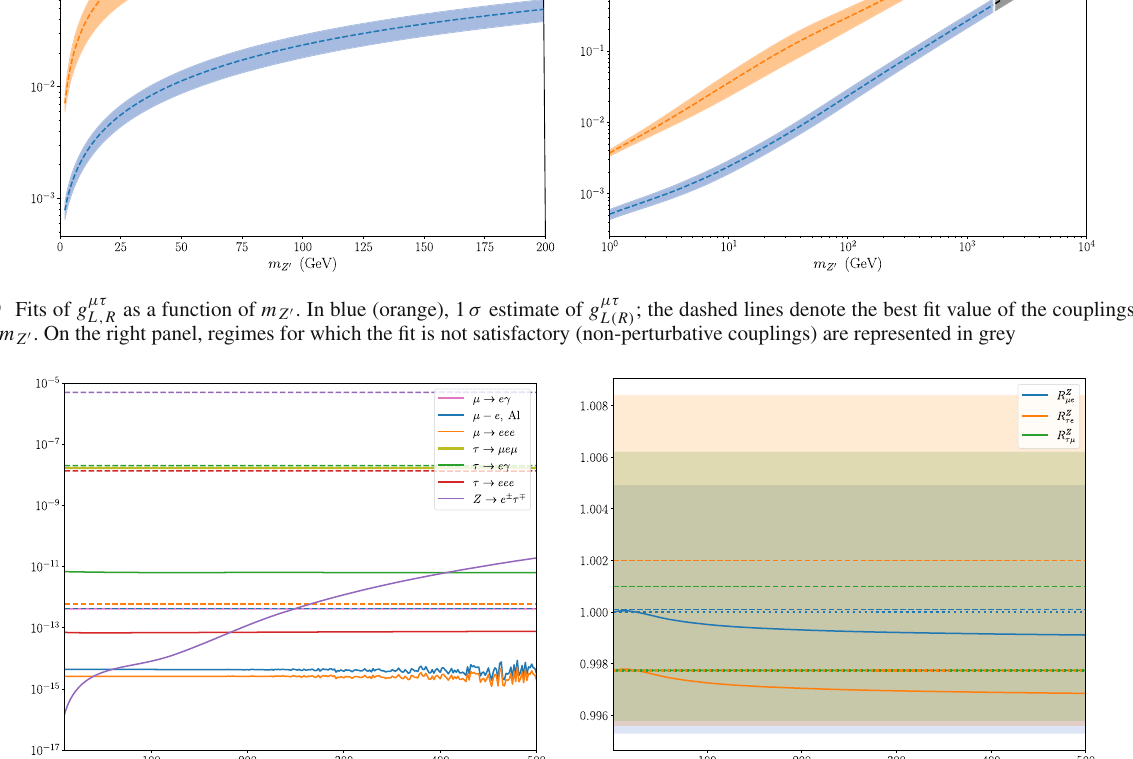
On the right panel, the coloured full (dotted) lines denote the model’s expectedupperlimit(SMprediction),whilethedashedlinesandshaded regionscorrespondtothecentralexperimentalvaluesandassociated2 σ